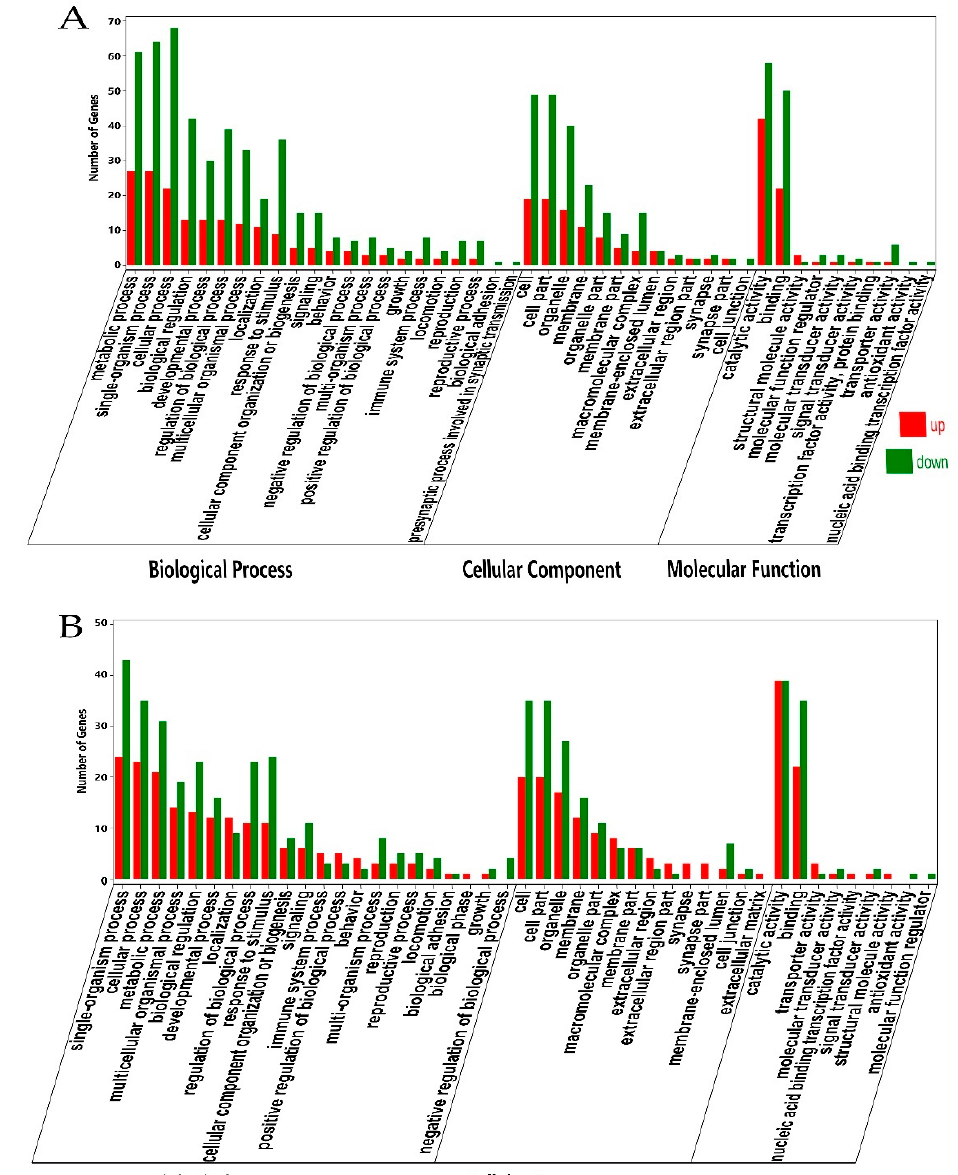
Figure 2. Gene ontology (GO) classification of the differentially expression genes in different ACB strains. ( A ) ACB-FR vs. ACB-BtS; ( B ) ACB-IeR vs. ACB-BtS. The abscissa is the second level GO term, the ordinate is the number of genes in the term, red column indicates up-regulation, and green column indicates down-regulation.